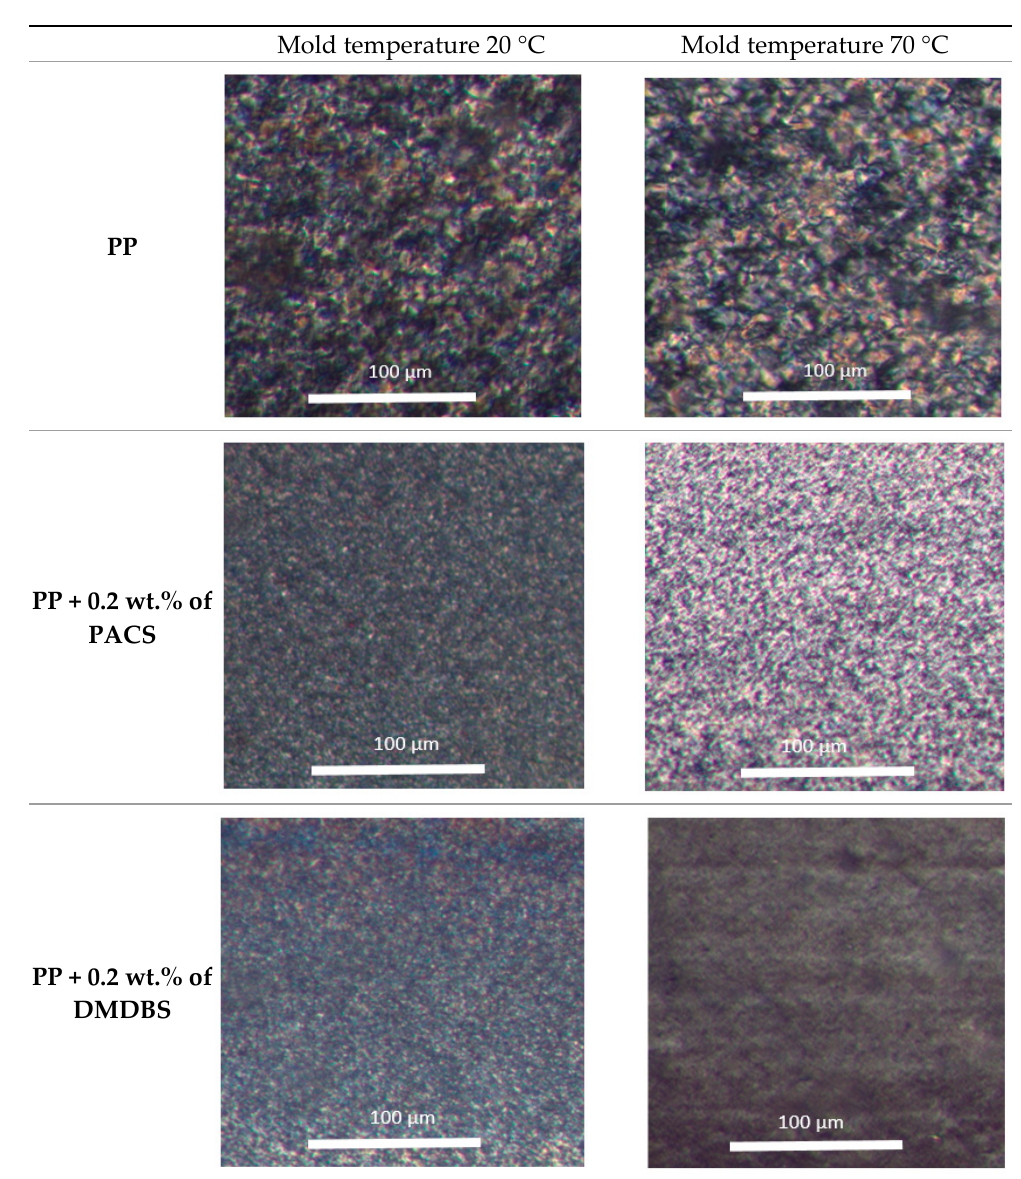
Table 3. The melting and crystallization temperature characteristic for both iPP crystal phases.